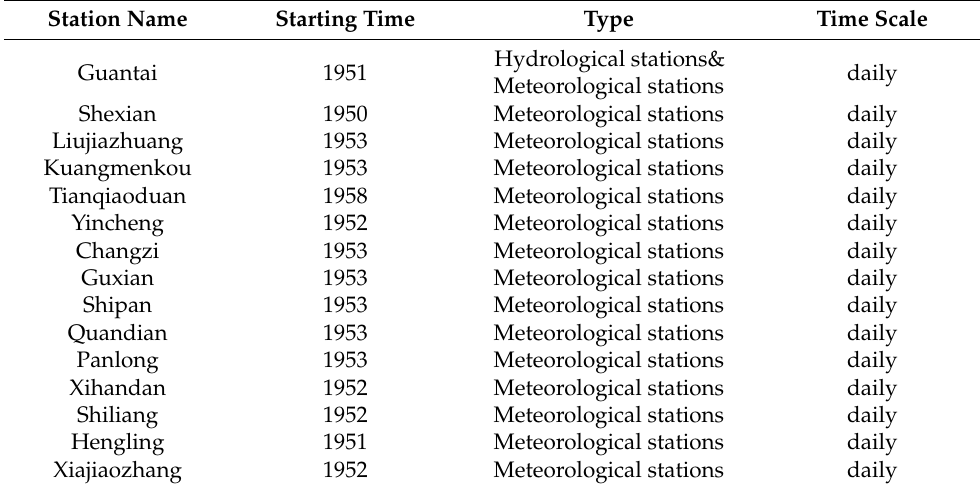
Table 1. The hydrological and meteorological station information used in this